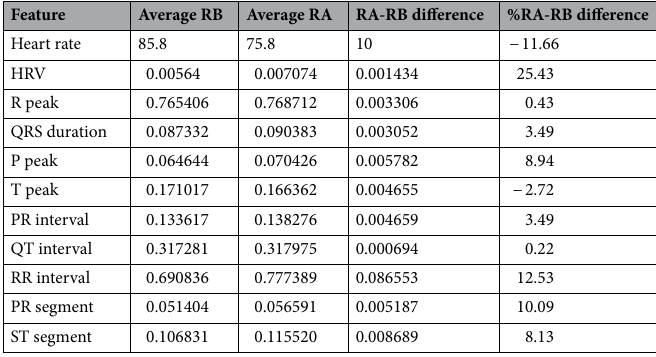
Table 4. The average values of ECG features before and after rehabilitation therapy.